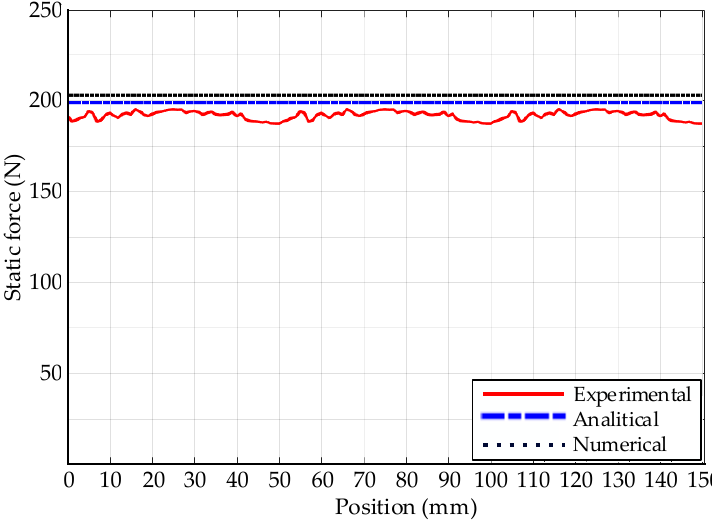
Figure 14. Static force versus position graphic.